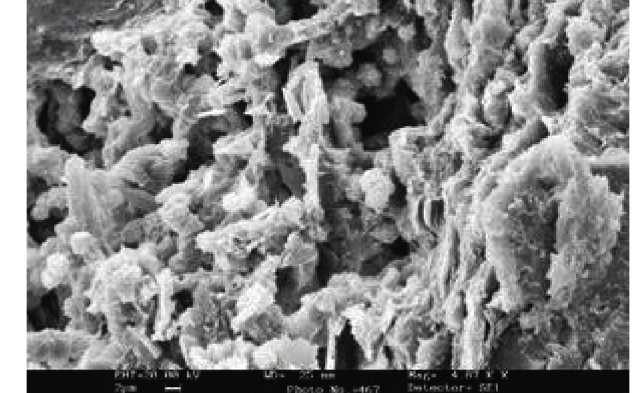
Figure 4: Microstructure of rock.